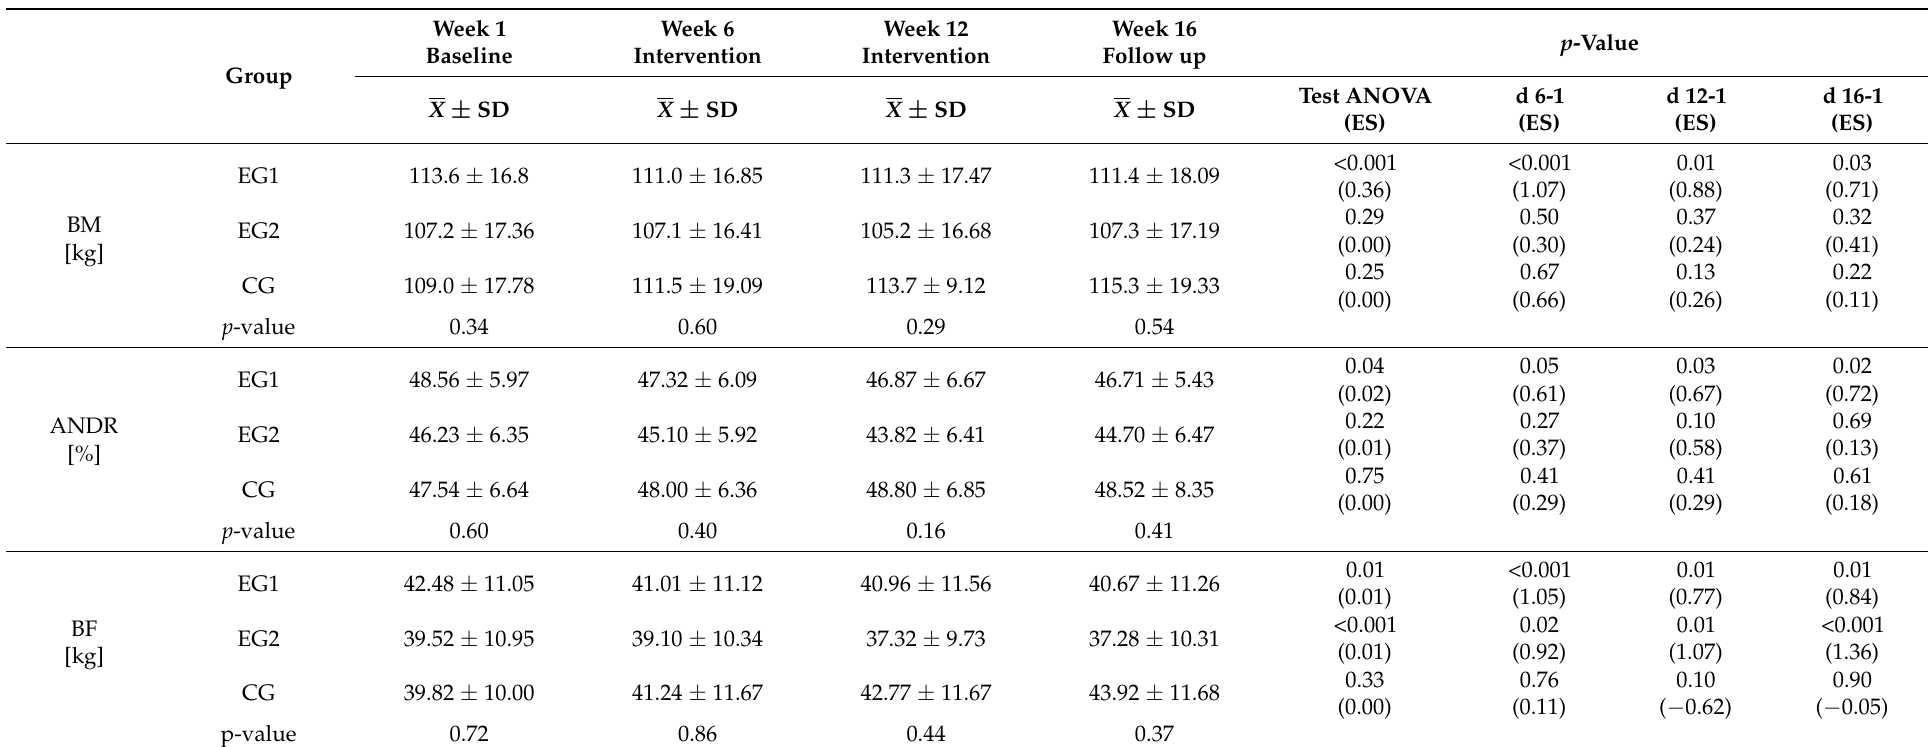
Table 2. Body composition: body mass (BM), body fat (BF) and android body fat (ANDR) in the aerobic group (EG1), aerobic-resistance group (EG2), and control group